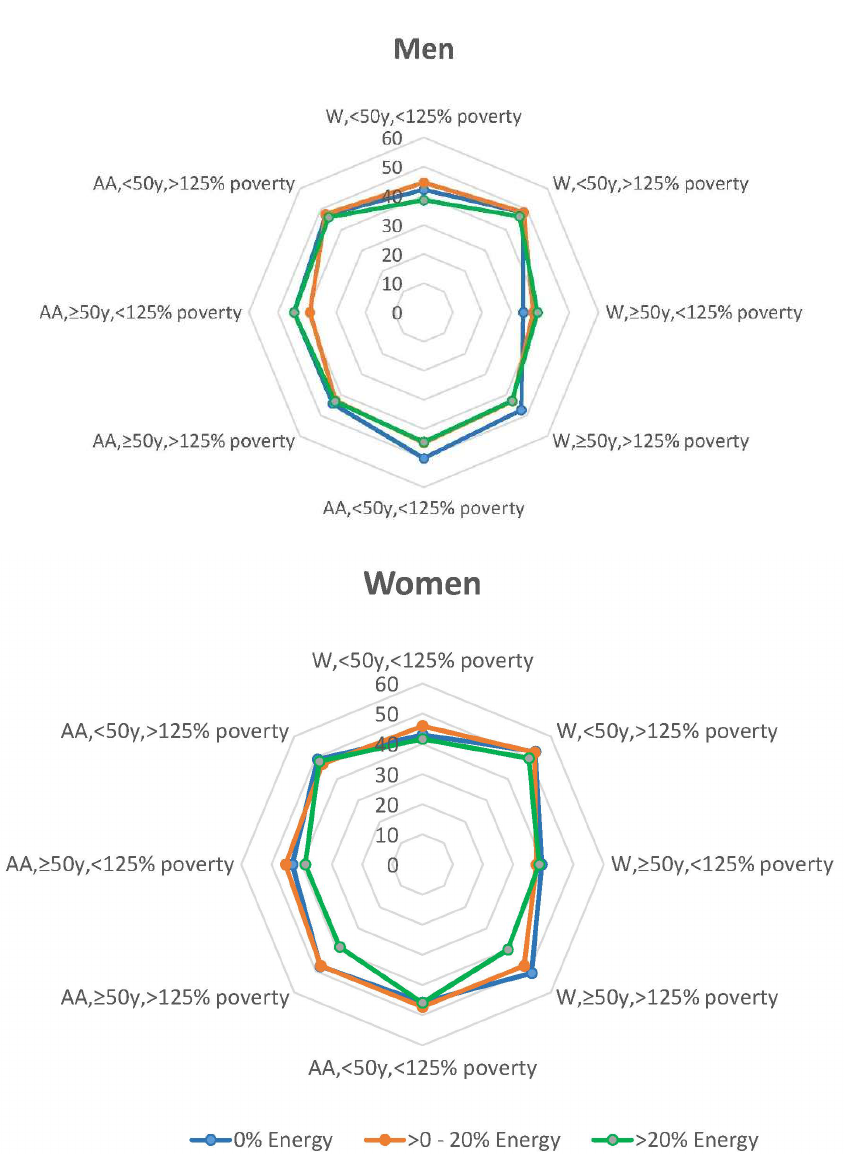
Figure 1. Healthy Eating Index (HEI) scores across three visits of the HANDLS study (2004–2017). For African American and White men and women by initial age cohort (<50 or ≥50 years at visit one) and by poverty (<125% or >125% poverty threshold) for three levels of energy intake (0%, >%–20%, >20% kcal) contributed by sandwiches. HANDLS-Healthy Aging in Neighborhoods of Diversity across the Life Span.